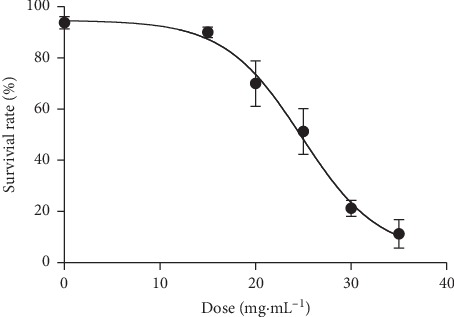
LC50 (24.83 mg/mL) of the hydromethanolic C. nutans extract leaf response among adult Drosophila melanogaster exposed to PQ in the feed. The results expressed in percentage of survivor flies presented correspond to the concentrations of the 15, 20, 25, 30, e 35 mg/mL. The test was effected in quadruplicate. R2 = 0.8997.